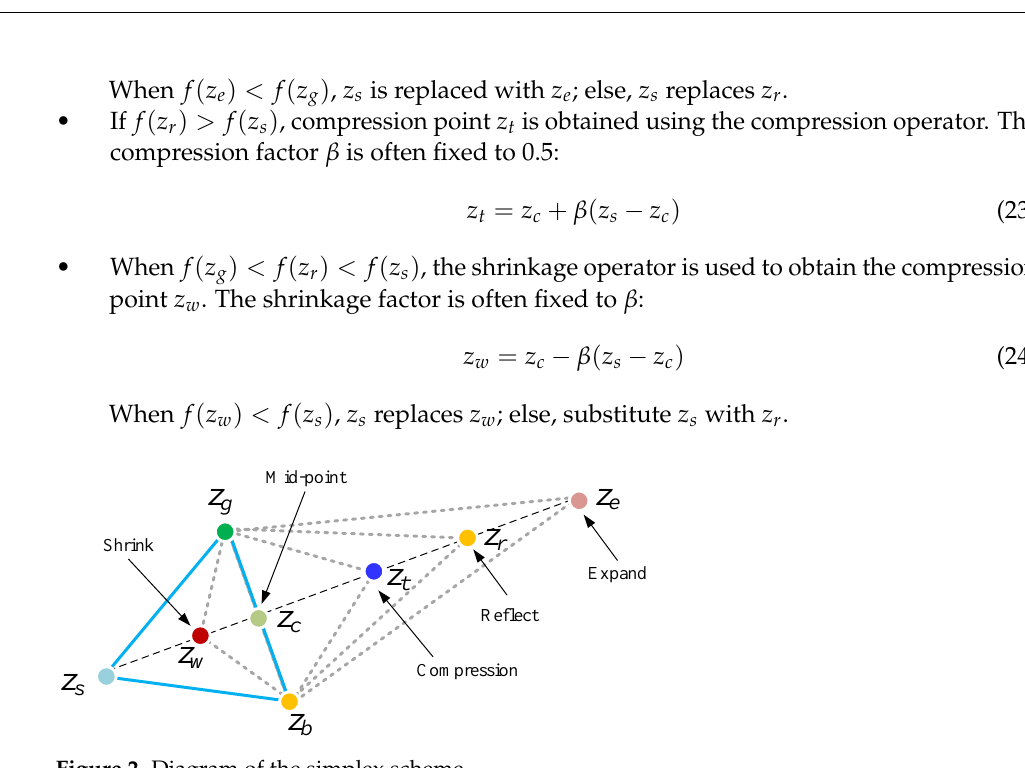
Figure 2. Diagram of the simplex